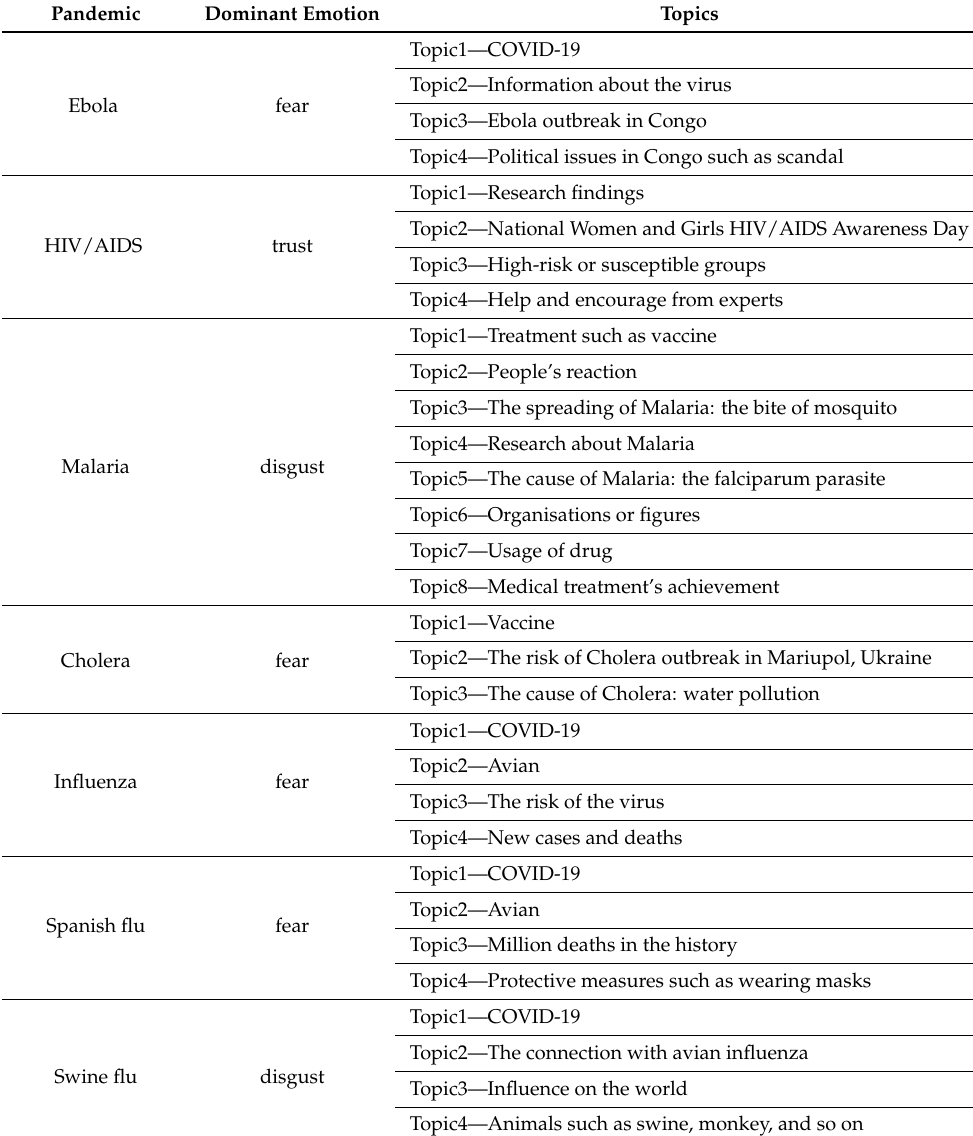
Table 4. Topics for pandemic and emotion pair: Ebola, cholera, influenza, and Spanish flu are listed with the fear emotion; HIV/AIDS is with the trust emotion; malaria and swine flu show topics with the disgust